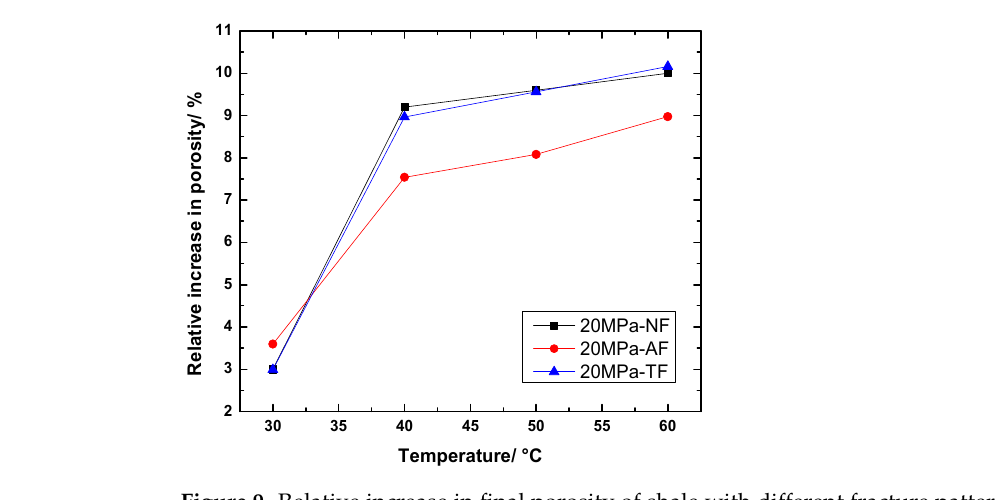
Figure 9. Relative increase in final porosity of shale with different fracture patterns after different temperatures over 6 h of scCO 2 treatment.